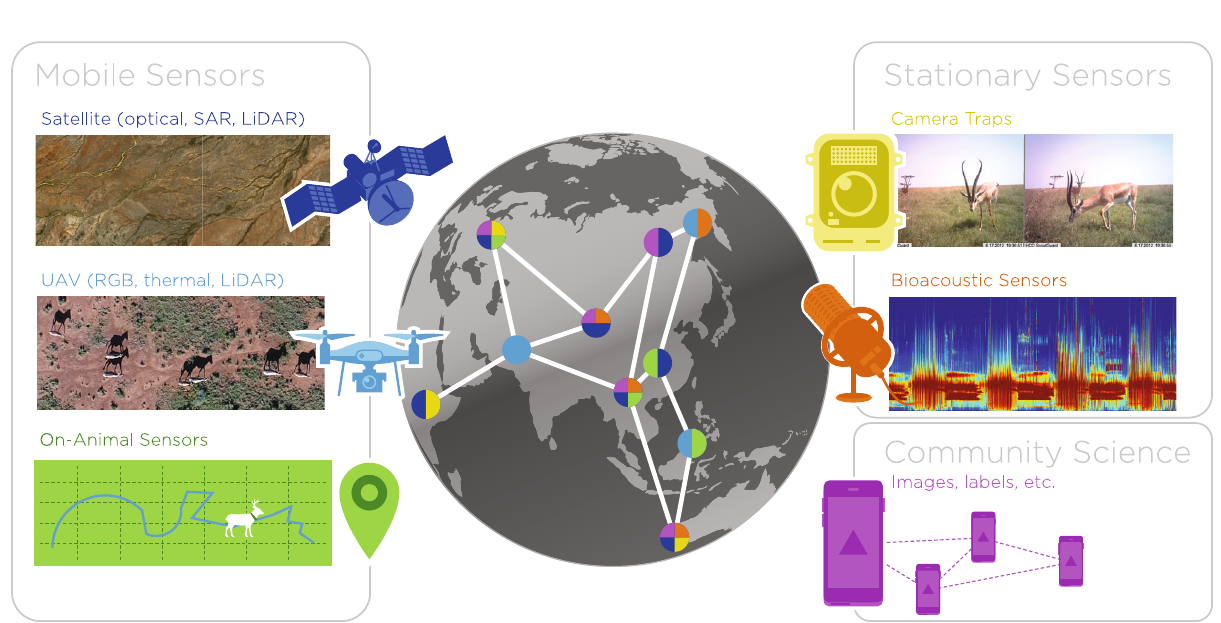
Fig. 3 A variety of sensors used in animal ecology. Studies frequently combine data from multiple sensors at the same geographic location, or data from multiple locations to achieve deeper ecological insights. Sentinel-2 (ESA) satellite image courtesy of the U.S. Geological